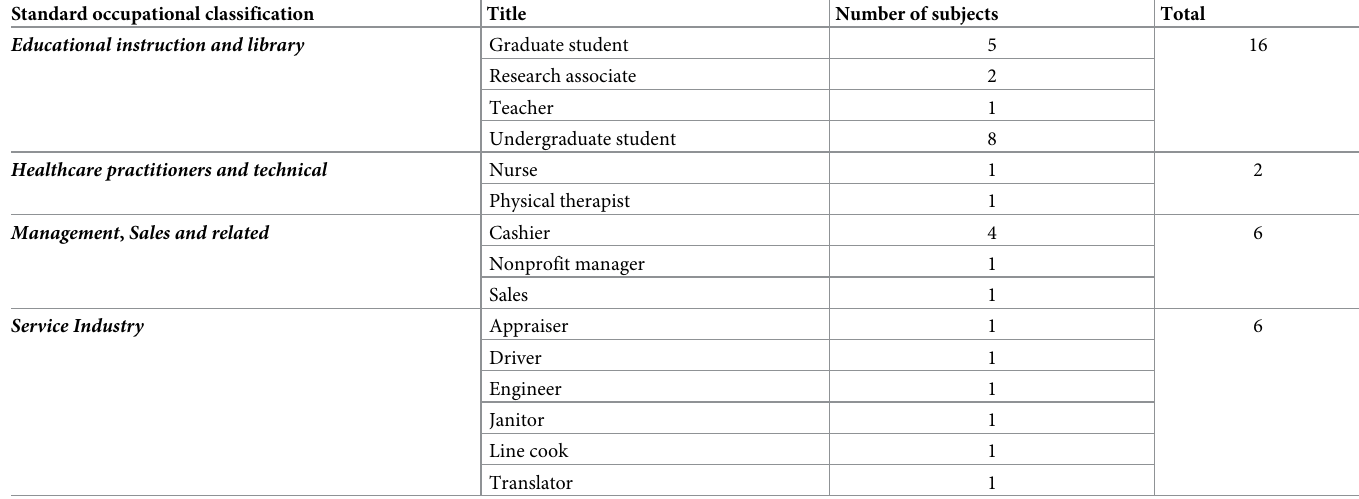
Table 4. Summary of subjects’ occupations. All the data are reported as number of subjects, and standard occupational classifications are based on the U.S. Bureau of Labor Statistics